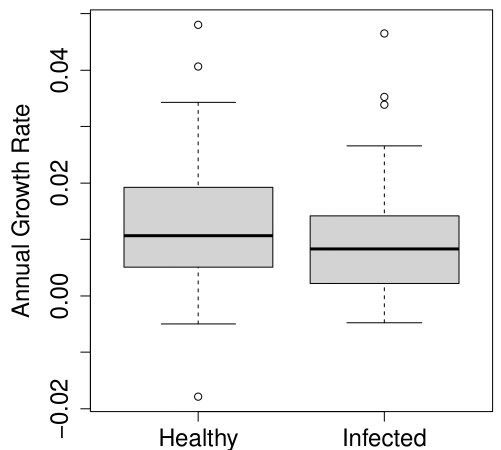
Figure 5. Distribution of relative growth rates for uninfected and infected